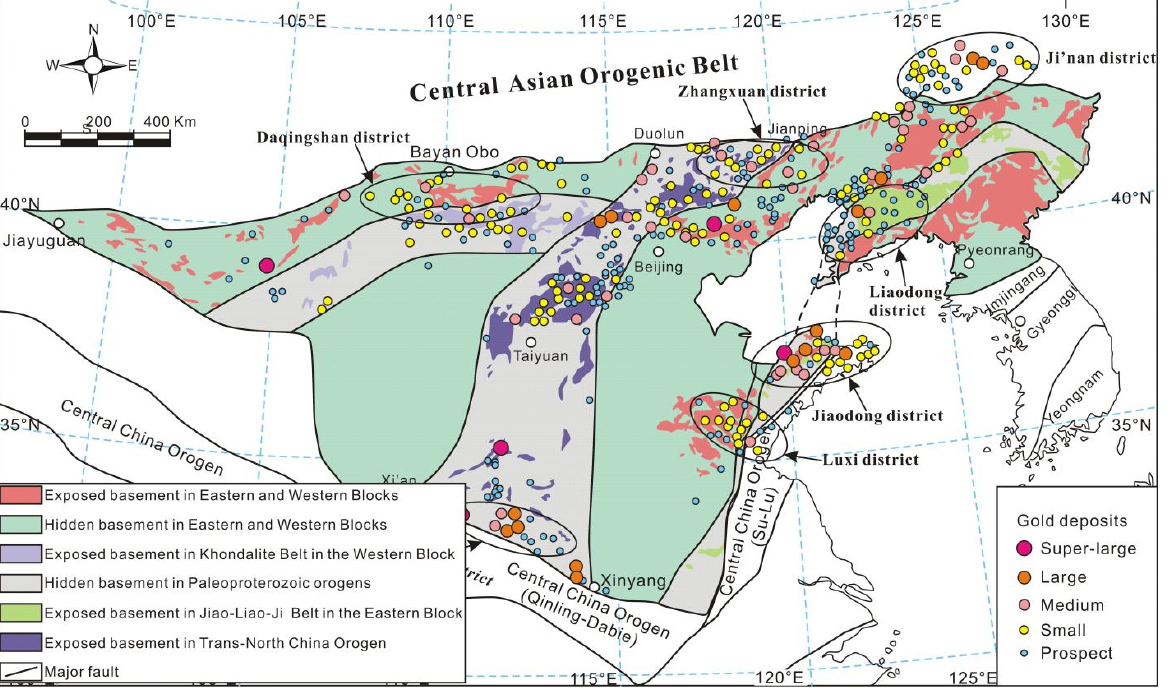
Figure 1. The distribution of gold deposits in the North China Craton (modified after Zhao et al. [12]; Deng and Wang [13]; He et al. [14]; Li and Santosh